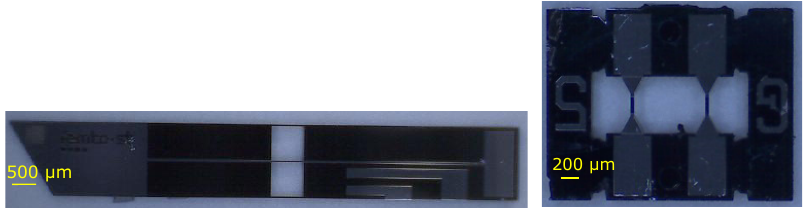
Figure 8. Fabricated